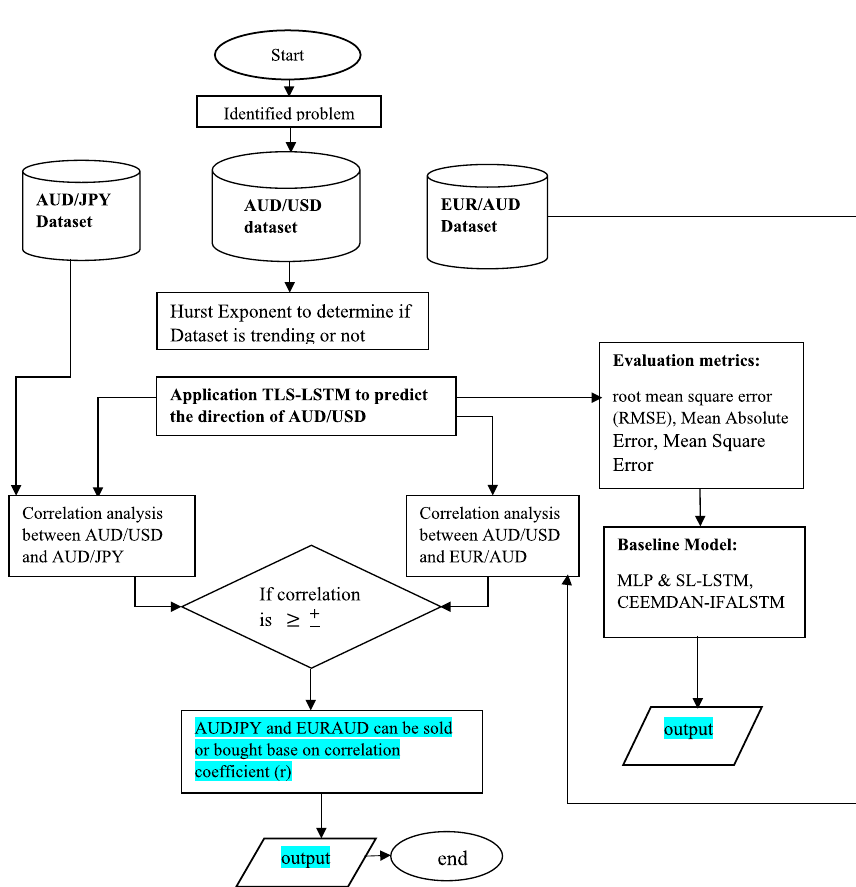
Fig. 3 Proposed conceptual